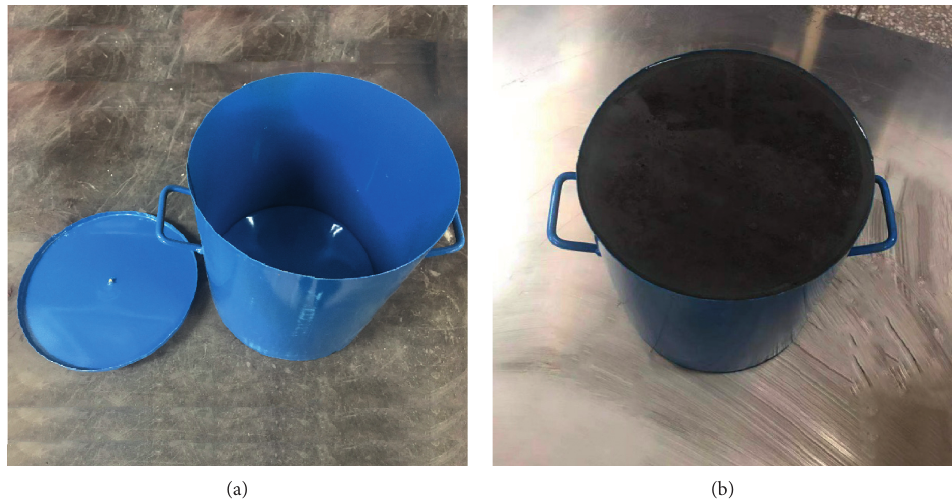
Figure 4: Graph of bleeding rate test. (a) Measuring device. (b) Bleeding rate